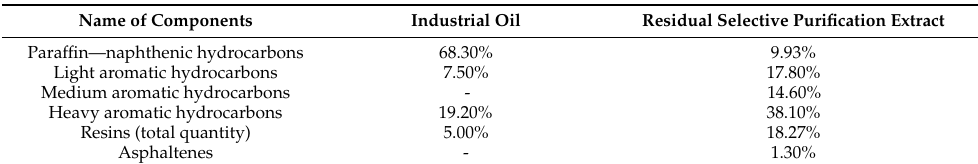
Table 2. Group composition of plasticizers.